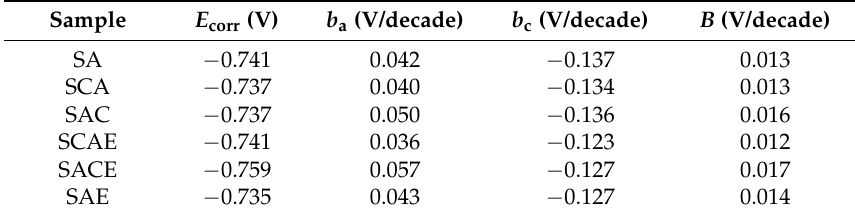
Figure 4. Polarization resistance ( R p ) and corrosion current density ( i corr ) of different AA6012 samples in aerated solution. In order to study possible differences of corrosion resistance among the different samples of AA6012 alloy (Table 1), further electrochemical tests were carried out by means of EIS technique. The samples were submitted to a short-term exposure in the aerated testing solution by performing EIS measurements at 0, 3, 6, and 24 h. Figure 5 shows six Nyquist plots obtained by EIS tests performed on representative samples of each series (Table 1), after 6 h of exposure. All plots showed two time constants: one at high frequencies, associated with a well-defined loop, which can be attributed to the parallel combination of a charge transfer resistance ( R t ) and a double layer constant phase element ( Q dl ); and another at low frequencies, associated with a quite scattered and not always well-defined inductive loop. In the